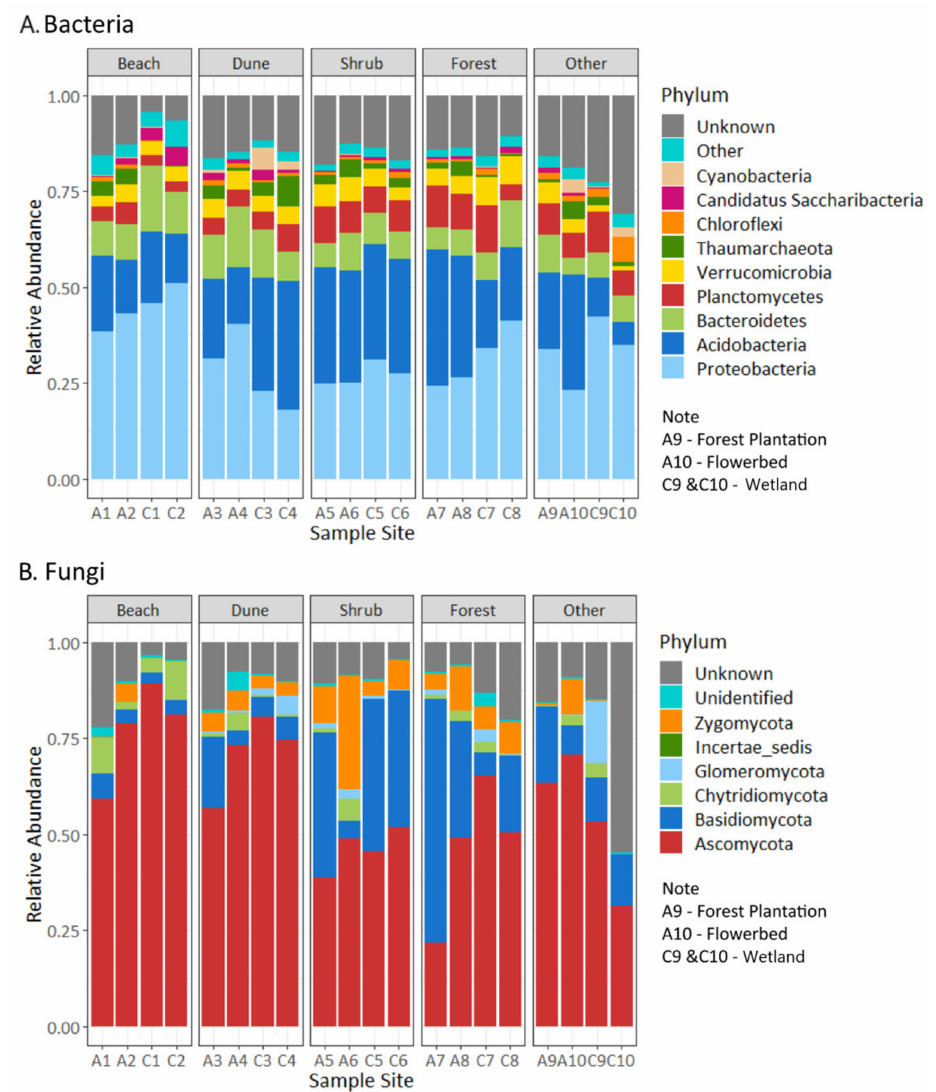
Figure 2. Phylum-level abundance from Albarella and Caleri. The taxa represented accounted for >1% abundance in at least one sampling point. Each ecosystem (beach, dune, shrub, forest, and other) is represented by two phytocoenosises corresponding to two sampling points and (with three repetitions in each point): 2 × 3 = 6